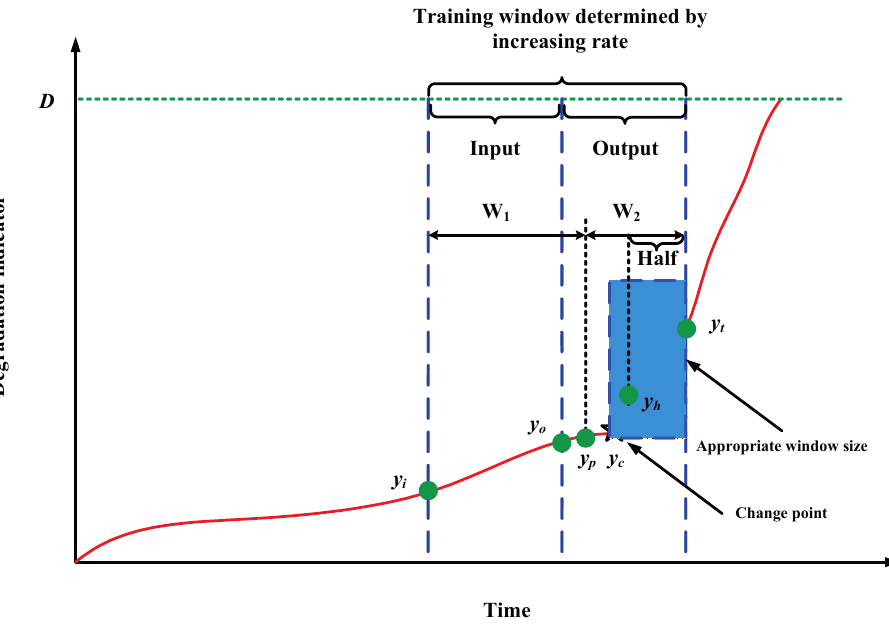
Figure 9. Schematic diagram of window adjusting when change point exists near prediction time t